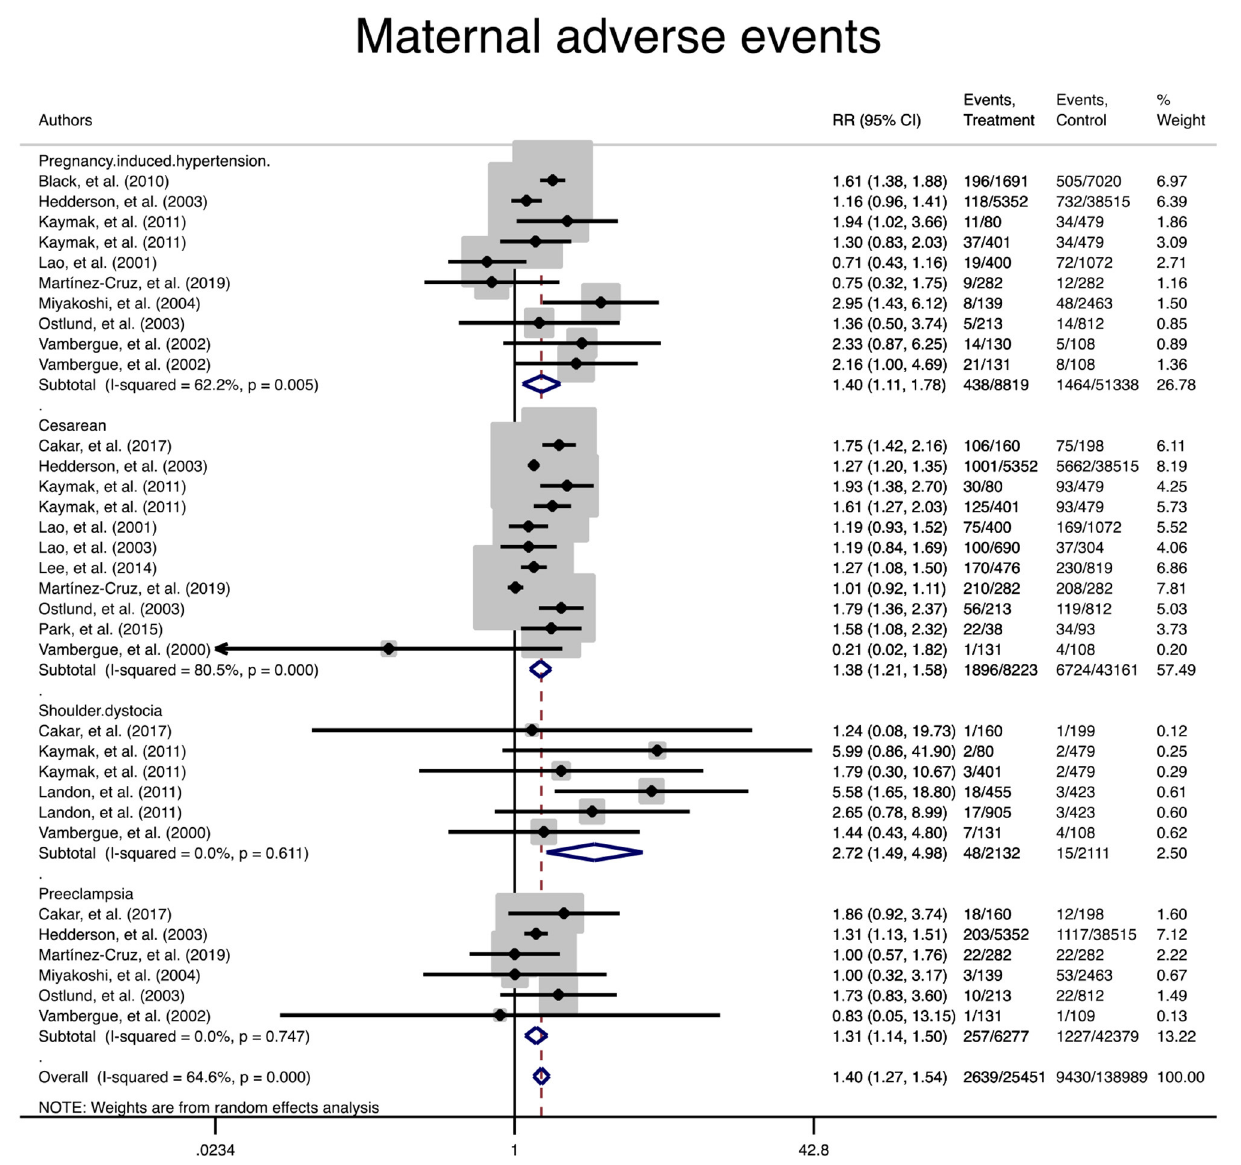
FIGURE 2 | Forest plot of pooled relative risk of adverse maternal